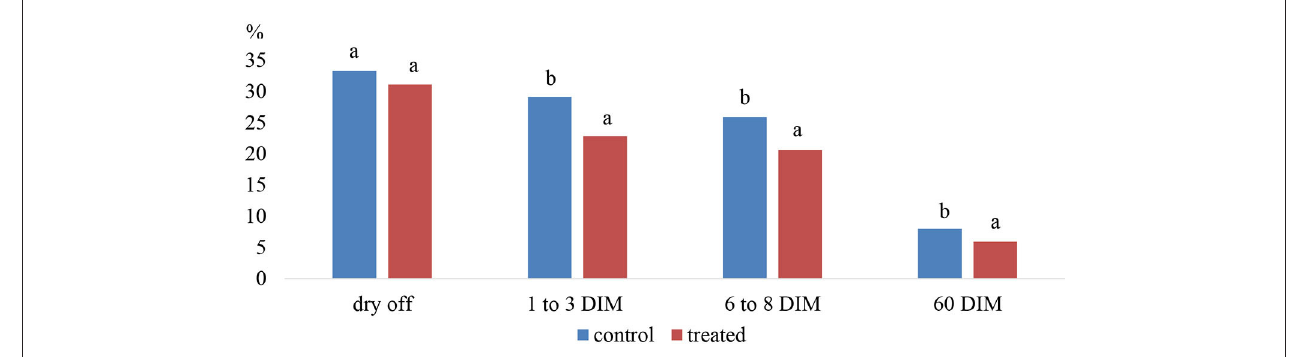
FIGURE 7 | Prevalence of IMI in control (antibiotic only) and treated (seal plus antibiotic) quarters at dry off, 1–3 days in milking (DIM), 6–8 DIM and 60 DIM. Note: a,b % of all quarters with IMI between columns are significantly different ( P < 0.05). Source: Adapted from Godden et al. (95).